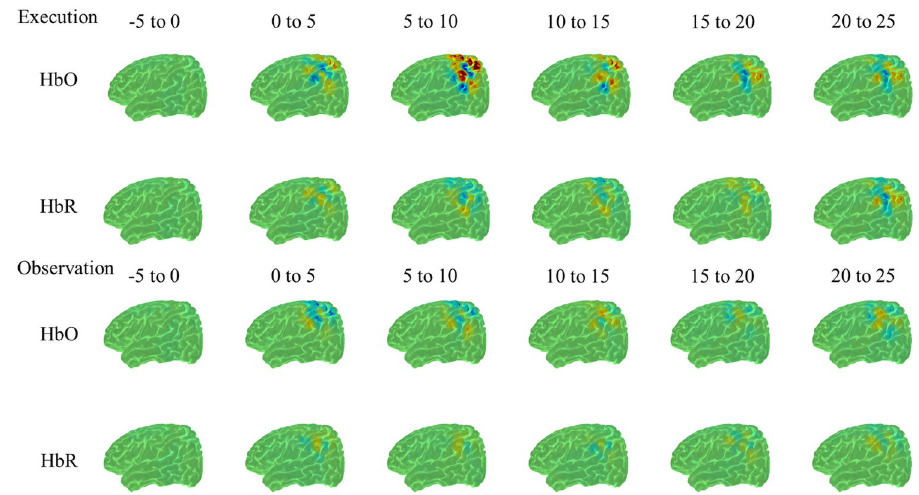
Fig 5. HbO and HbR reconstruction maps for execution and observation in the left hemisphere from -5 to 25 seconds.